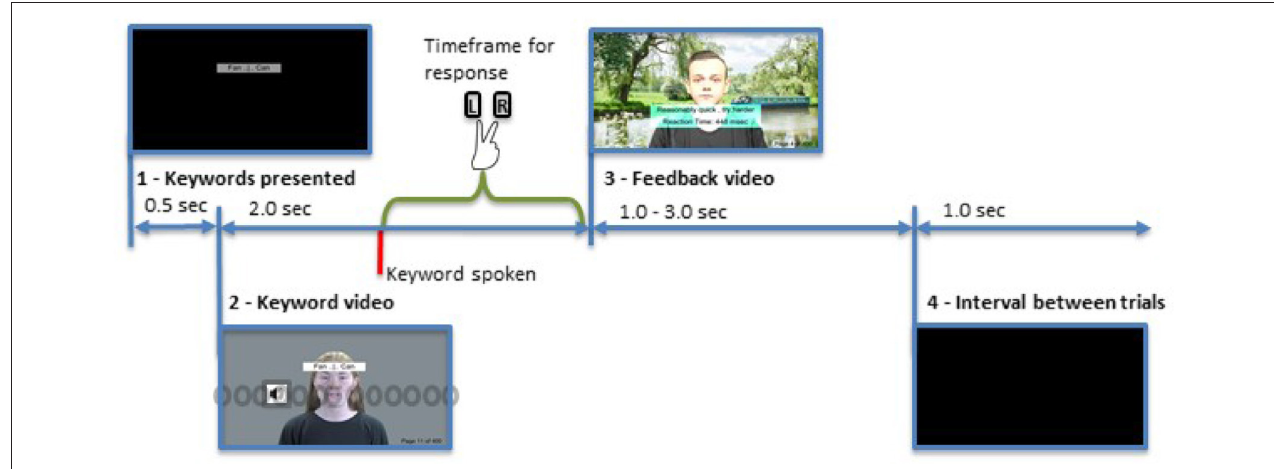
FIGURE 5 | Representation of the trial sequence. Illustrated is a standard trial with audio presented at 10 ◦ left. The keywords are presented for 0.5 s, followed by a video of the sentence. The keyword is spoken at 1.0s within the video. The feedback is presented once a response is given. After an interval of 1.0s the next trial starts. The gray circles indicate the position of the loudspeakers and the symbol denotes the currently active one. Written informed consent for publication of all personal images was obtained (CC BY-NC